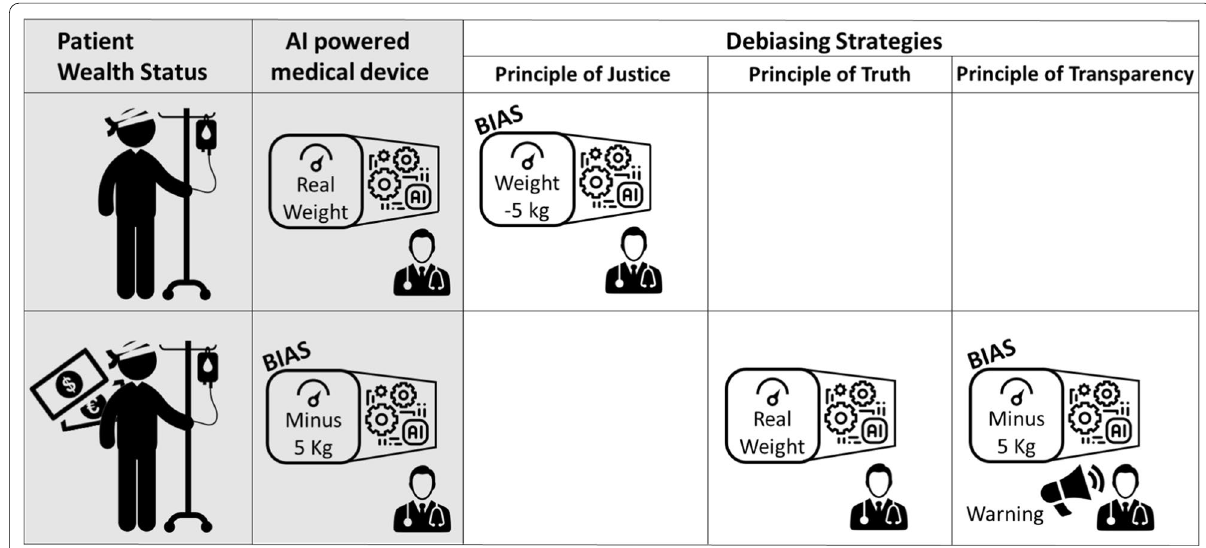
Fig. 1 An artificial intelligence powered diagnostic tool in radiology presented as a weighing scale for understanding. The tool reduces the weight of a rich person by 5 kg but uses the actual weight of a poor person. It is unfairly biased in favor of rich people leading to these patients being diagnosed as overweight less frequently. To resolve the bias, if one prioritizes the principle of equity, and reduces the weight of a poor person by 5 kg as well, the outcome of the scale is wrong for both groups of patients. If one focuses on obtaining a correct weight for all the patients, one can cancel the error on the biased scale or inform the user that the result may be biased. In conclusion, in terms of debiasing strategy, the patient’s medical interest prevails over the principle of social equity. AI Artificial